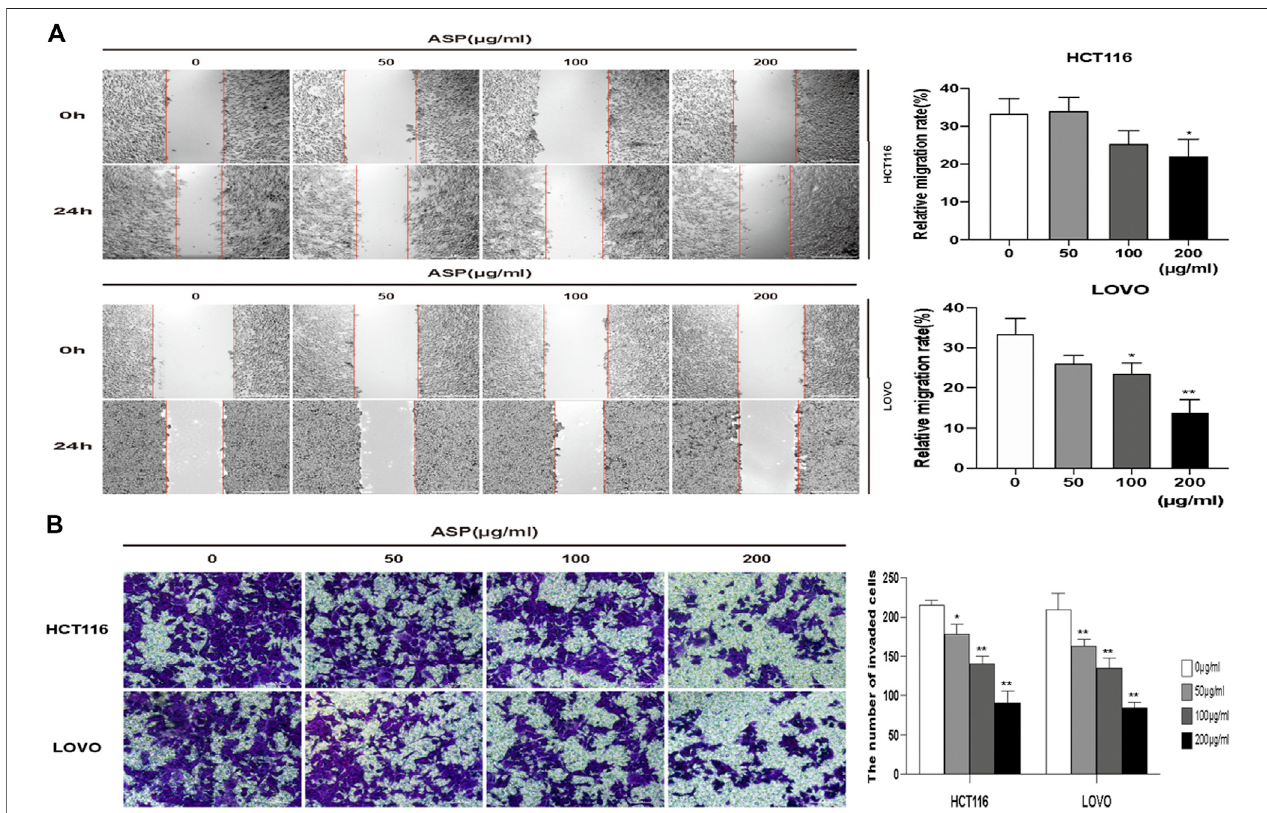
FIGURE8| ASPinhibitsthemigrationandinvasionofhumanCRCcells (A) WoundhealingmigrationassayofHCT116andLOVOcellsunderASPtreatment(×40), n = 5. (B) Transwell invasion assay of HCT116 and LOVO cells under ASP treatment (×100), n = 6. * p < 0.05, ** p < 0.01 vs . the control.